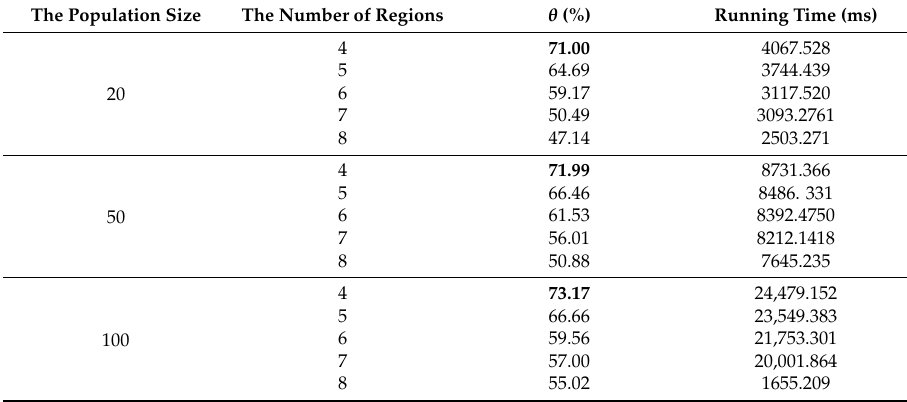
Table 4. The relationship between θ and running time for each population size.